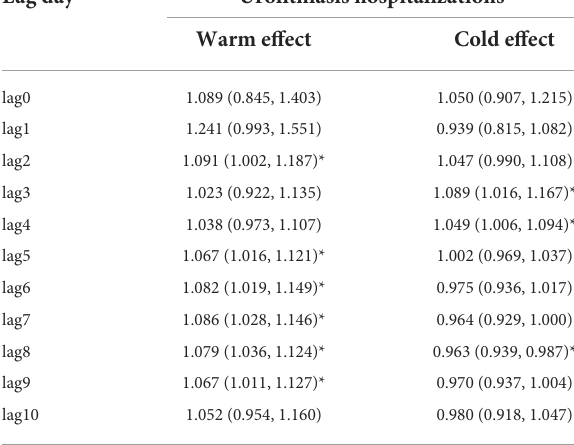
TABLE 2 Warm and cold effects of temperature on urolithiasis hospitalizations at different lag days.